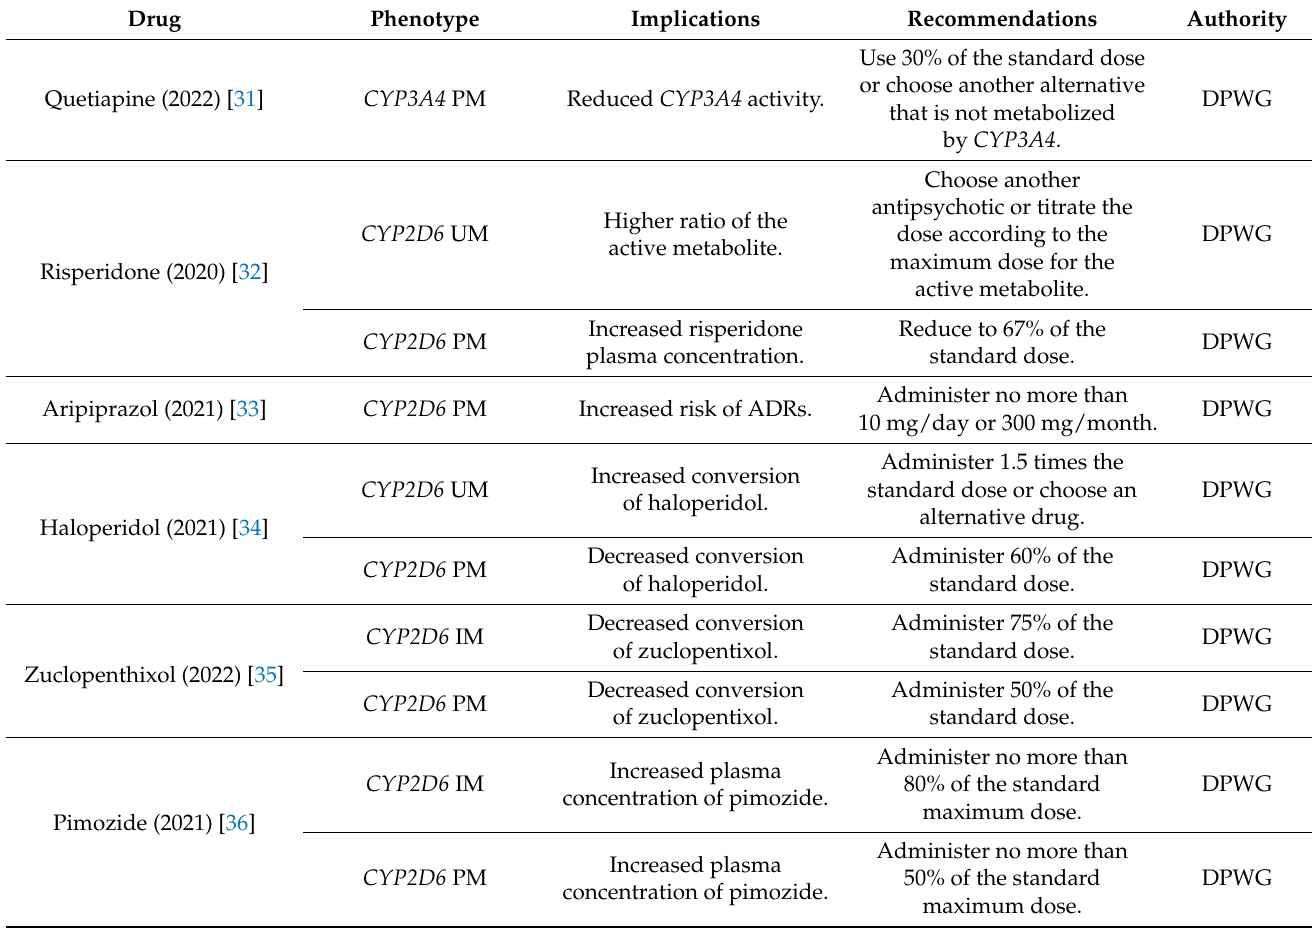
Table 5. Pharmacogenetic guidelines published to date on antipsychotic